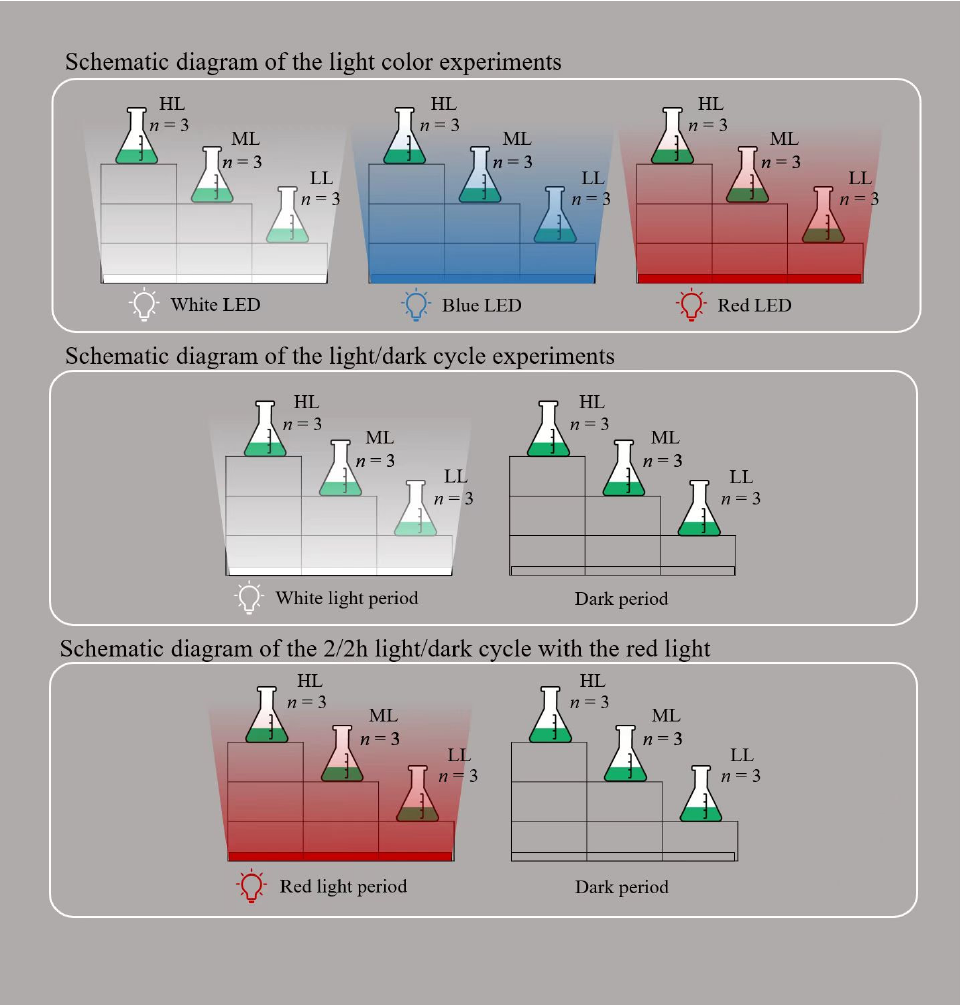
Figure 1. Schematic diagram of the experimental setup. To evaluate the influence of different light/dark cycles, four treatments were estab- lished. The 2/2 s group: a two-second dark period and two-second light period with white light; the 2/2 h group: a two-hour dark period and two-hour light period with white light; the 6/6 h group: a six-hour dark period and six-hour light period with white light; the 24/0 h group: the use of white LEDs with continuous light exposure. These experimental groups were subjected to white light under different light intensities, includ- ing 18 µ mol/m 2 · s (LL), 55 µ mol/m 2 · s (ML), and 110 µ mol/m 2 · s (HL), for 9 days. The continuous white light exposure group, 18 µ mol/m 2 · s, was used as the control treatment. Based on the results from the treatments mentioned above, the 2/2 h light/dark cycle with red-light treatment was used to promote H. lacustris growth in the green stage.